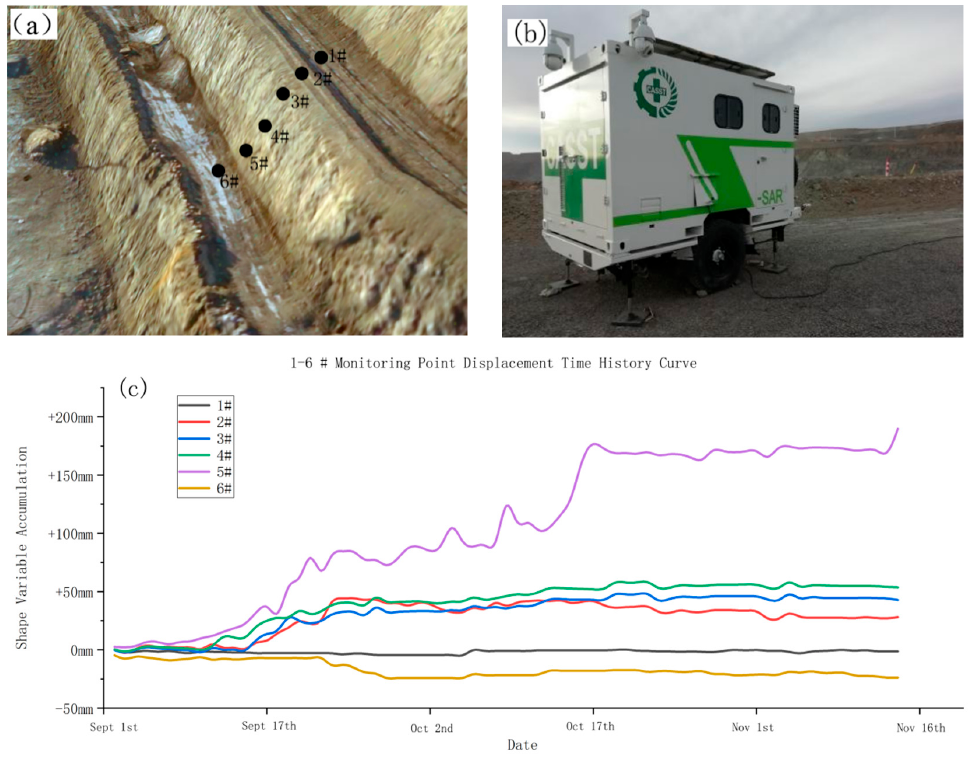
Figure 4. Surface displacement monitoring: ( a ) Displacement-monitoring point; ( b ) Trailer radar; ( c ) Displacement time history curve of monitoring point.